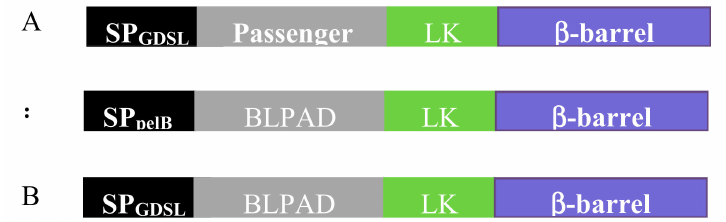
Figure 1. Schematic representation of the hybrid constructs for cell surface display of phenolic acid decarboxylase (BLPAD). ( A ) The wild GDSL autotransporter. ( B ) The BLPAD chimera with a PelB